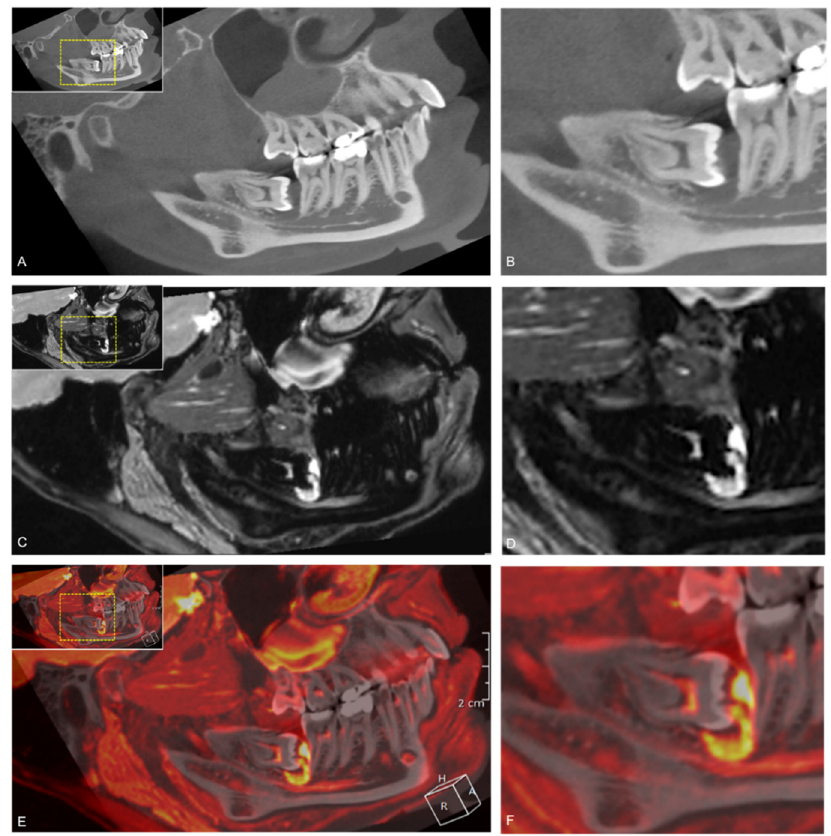
Figure 8. Fusion of study participant’s 3D-DESS MRI (red) and CBCT (gray). ( A ) Sagittal CBCT reconstruction showing an impacted mandibular third molar with mesial angulation and surrounding follicular cyst; ( C ) Sagittal DESS MRI visualizing an inflammatory process originating from the follicular cyst, which impressively displaces the IAN within the IAC; and ( E ) Fused CBCT-MRI scans visualizing the inflammatory process. For orientation, the dotted rectangles in the corner show the enlarged area in CBCT ( B ), MRI ( D ), and fused CBCT/MRI scans ( F ).